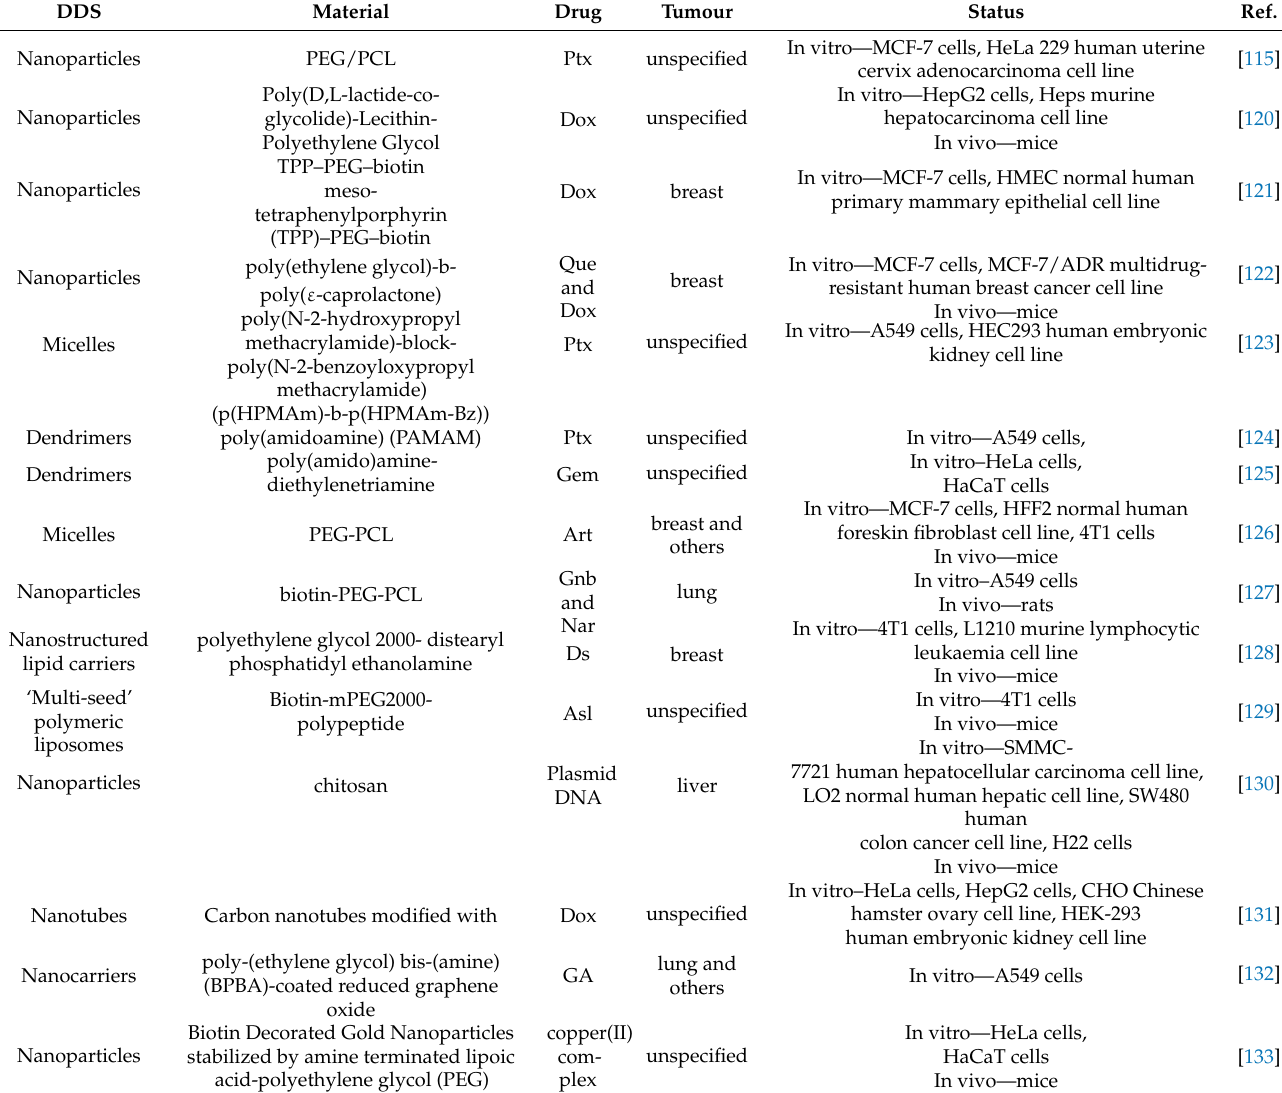
Table 4. Examples of biotinylated nanosystems developed for anti-cancer